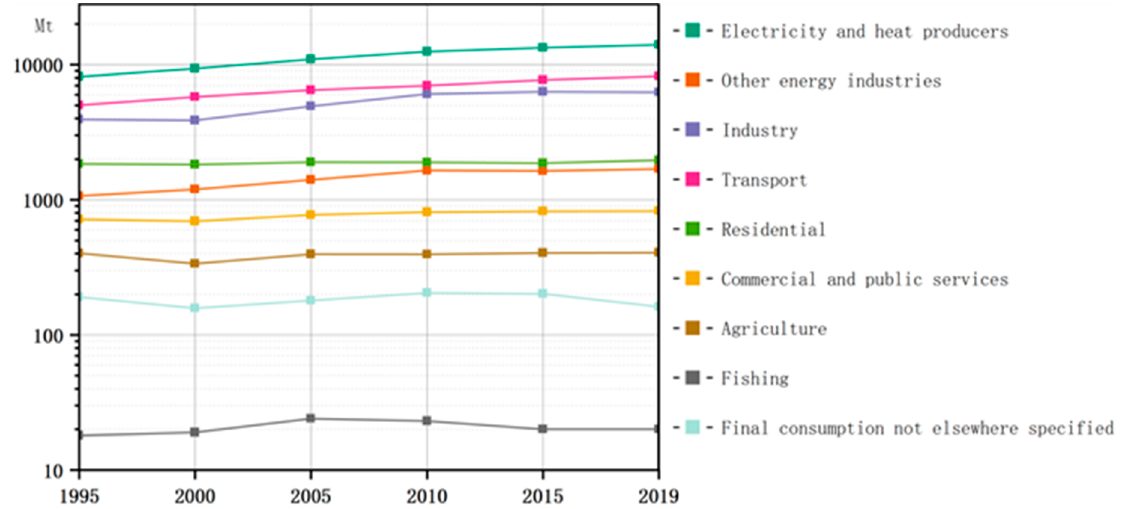
Figure 1. CO 2 emission table by